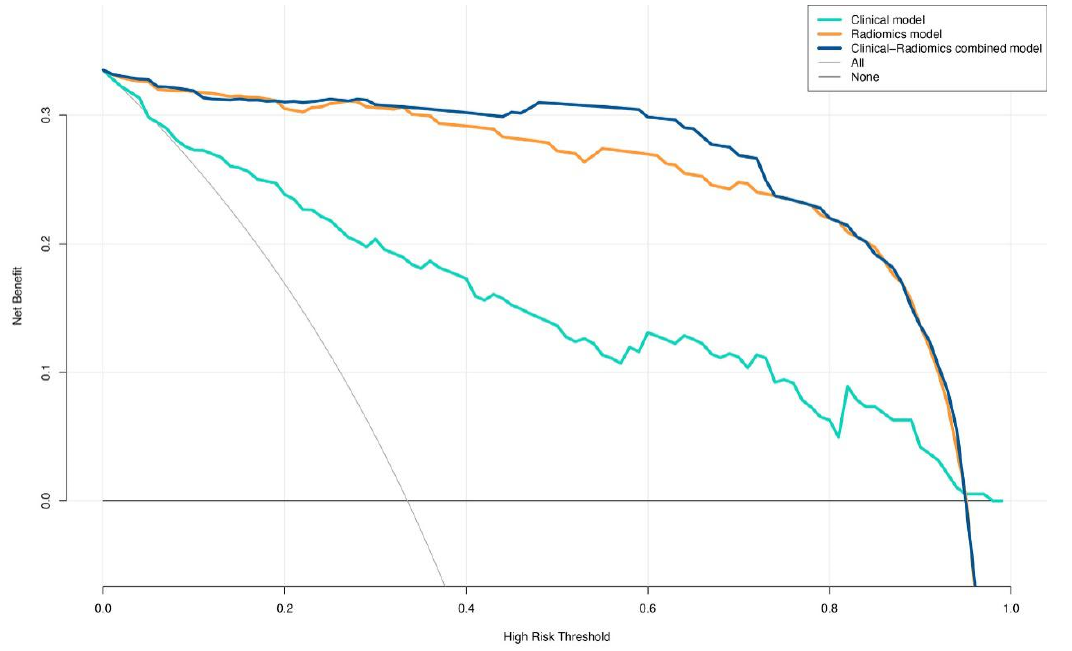
Figure 7. Decision curves of the clinical, radiomics, and clinical-radiomics combined models for predicting PCa in the validation cohort.